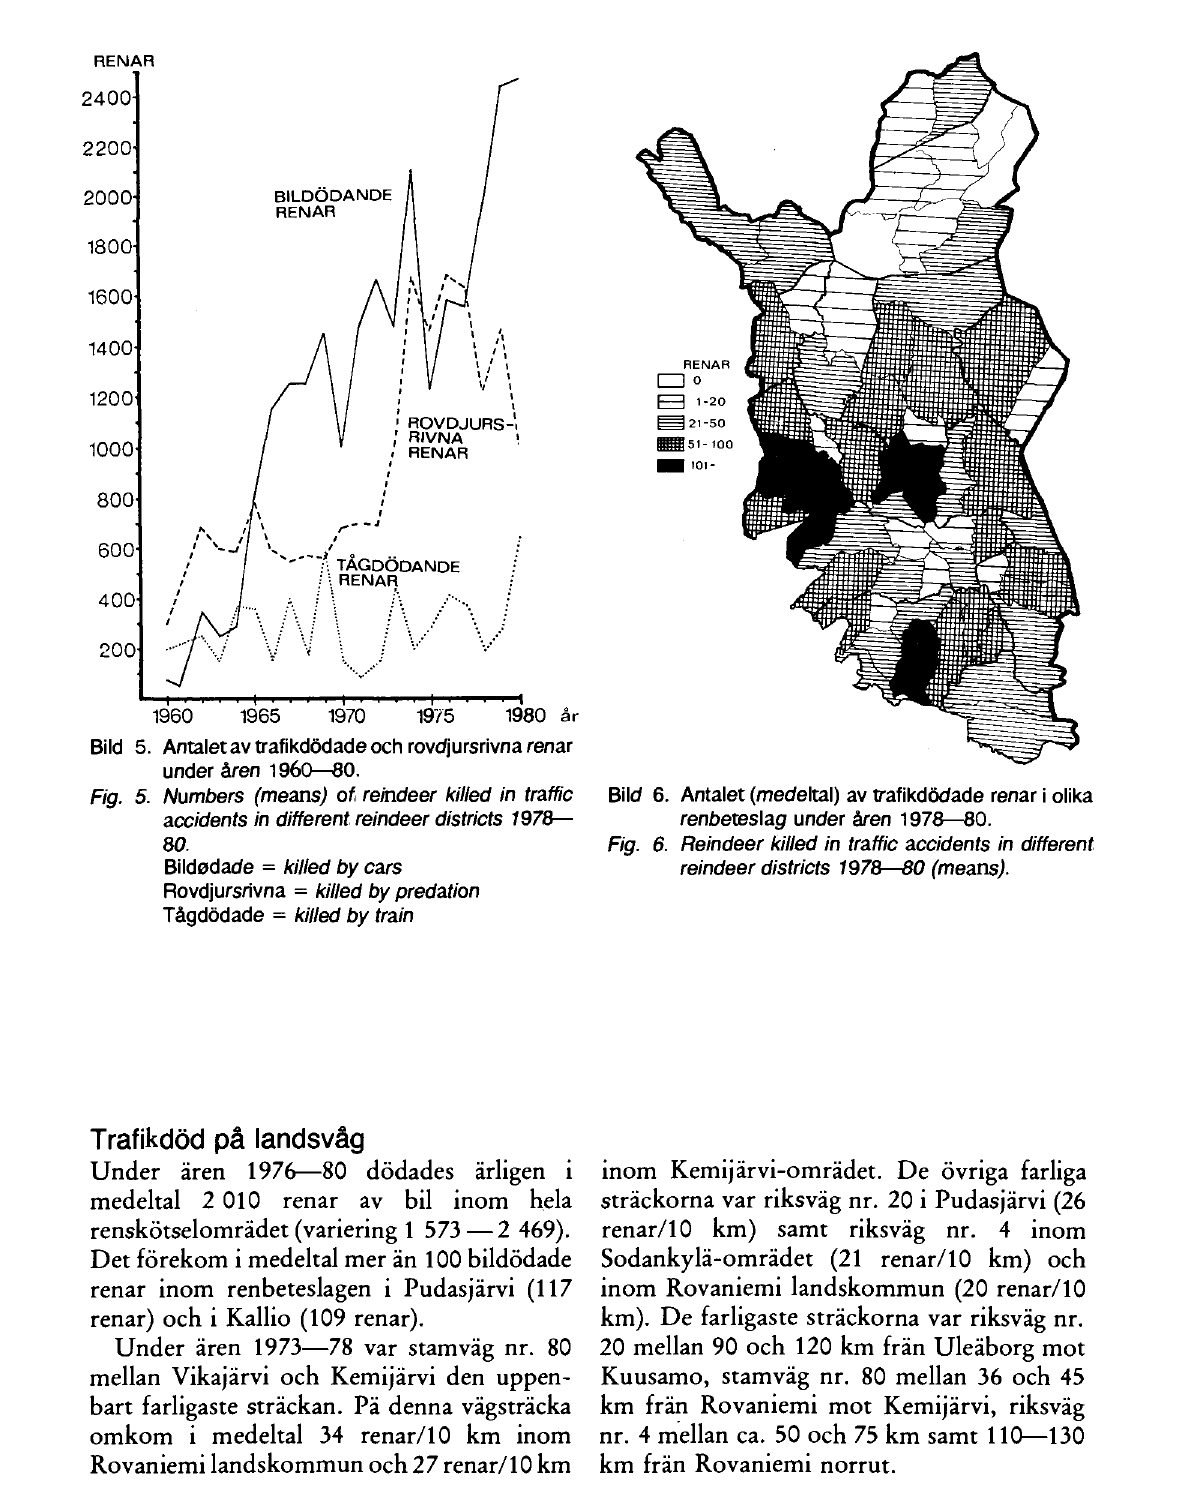
Bild 6. Antalet (medeltal) av trafikdôdade renar i olika renbeteslag under åren 1978—80. Fig. 6. Reindeer killed in traffic accidents in different reindeer districts 1978—80